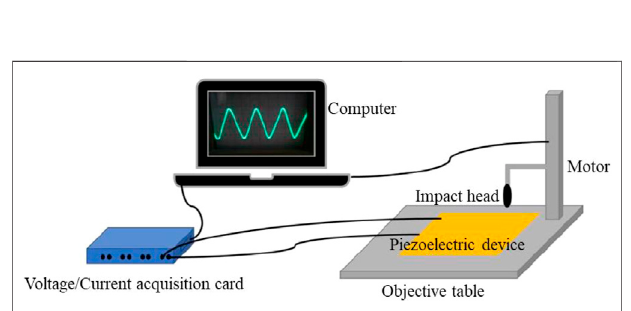
FIGURE 2 | Energy harvesting experiment diagram of PVDF-TrFE fi lms.